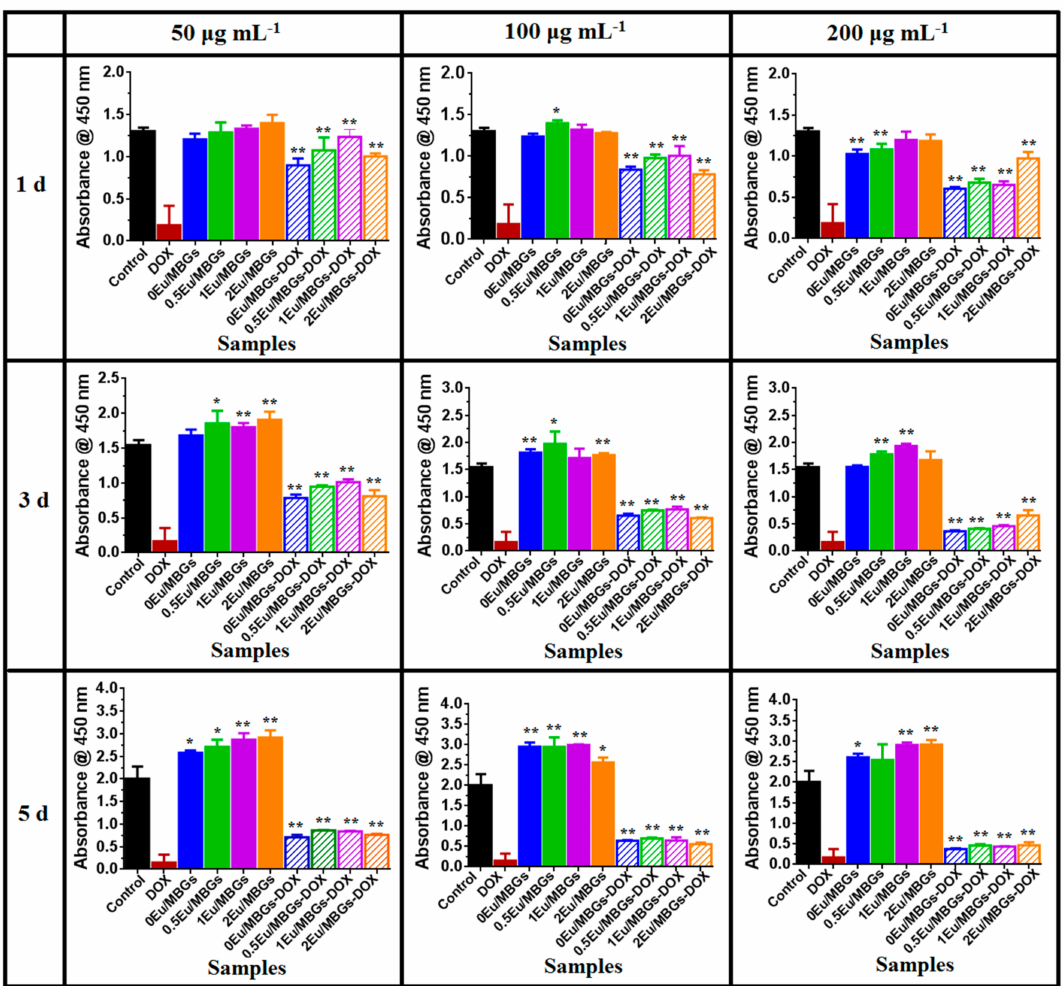
Figure 7. The effects of Eu/MBGs and Eu/MBGs-DOX (50, 100 and 200 µ g mL − 1 ) on the viability of osteosarcoma MG 63 cells at 1, 3 and 5 days. Data are expressed as the mean ± standard deviation of three independent experiments. *: p < 0.05, **: p <